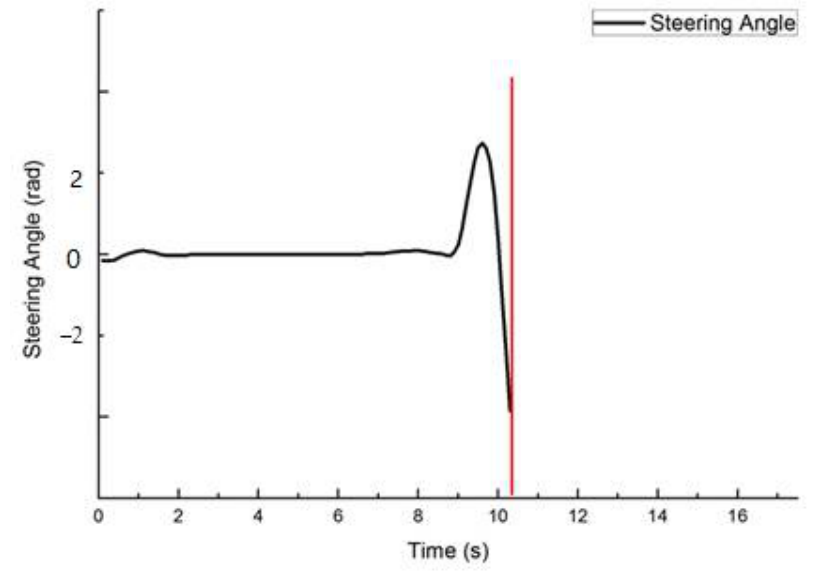
Figure 2. The relationship between steering wheel angle and time.